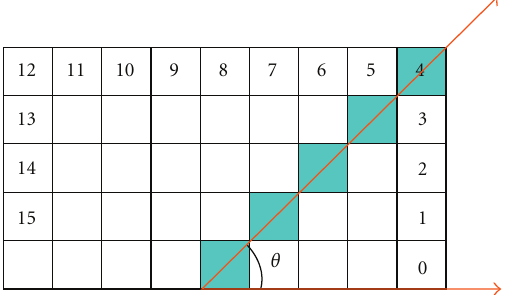
Figure 6: Extraction of the edge-direction distribution using 16